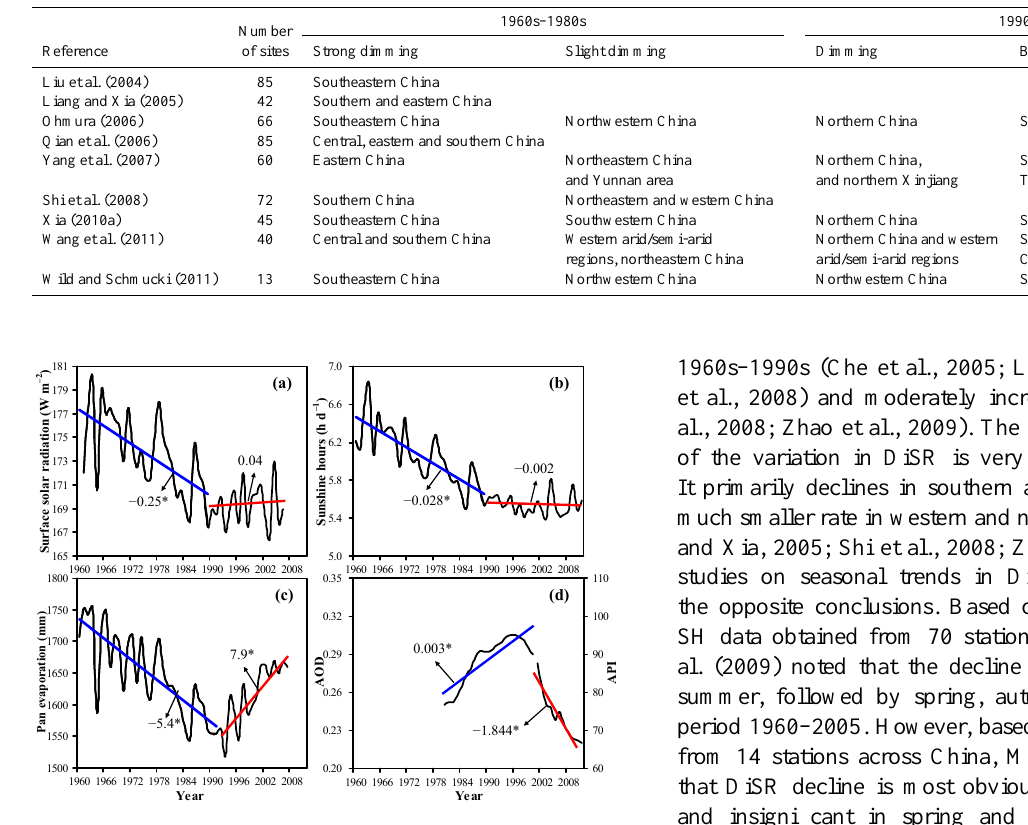
Fig. 2. Time series comparisons of annually averaged surface solar radiation (A, data from Tang et al. (2011)), sunshine hours (B, data from Wang et al. (2013)), pan evaporation (C, data from Liu et al. (2011a)), AOD and API (D, data from Streets et al. (2008) and Wang et al. (2013) for 1980 − 2000 and 2001 − 2011, respectively) over China for the 1960s − 2000s. Blue lines denote linear trends in dimming phase and red lines indicate linear trends in brightening phase. Values are trend slopes and asterisks denote a significant trend at the 95% confidence level.